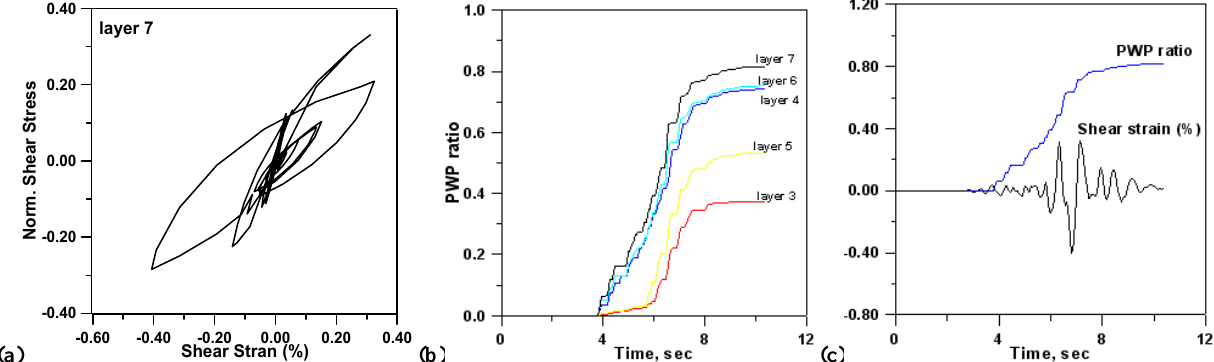
(b) Fig. 18. Stress-strain history (a) for the layer with high probability to liquefy; PWP time histories at different ground level (b) ; PWP and shear strain time histories (c) for the layer with high probability to Figure 18 .